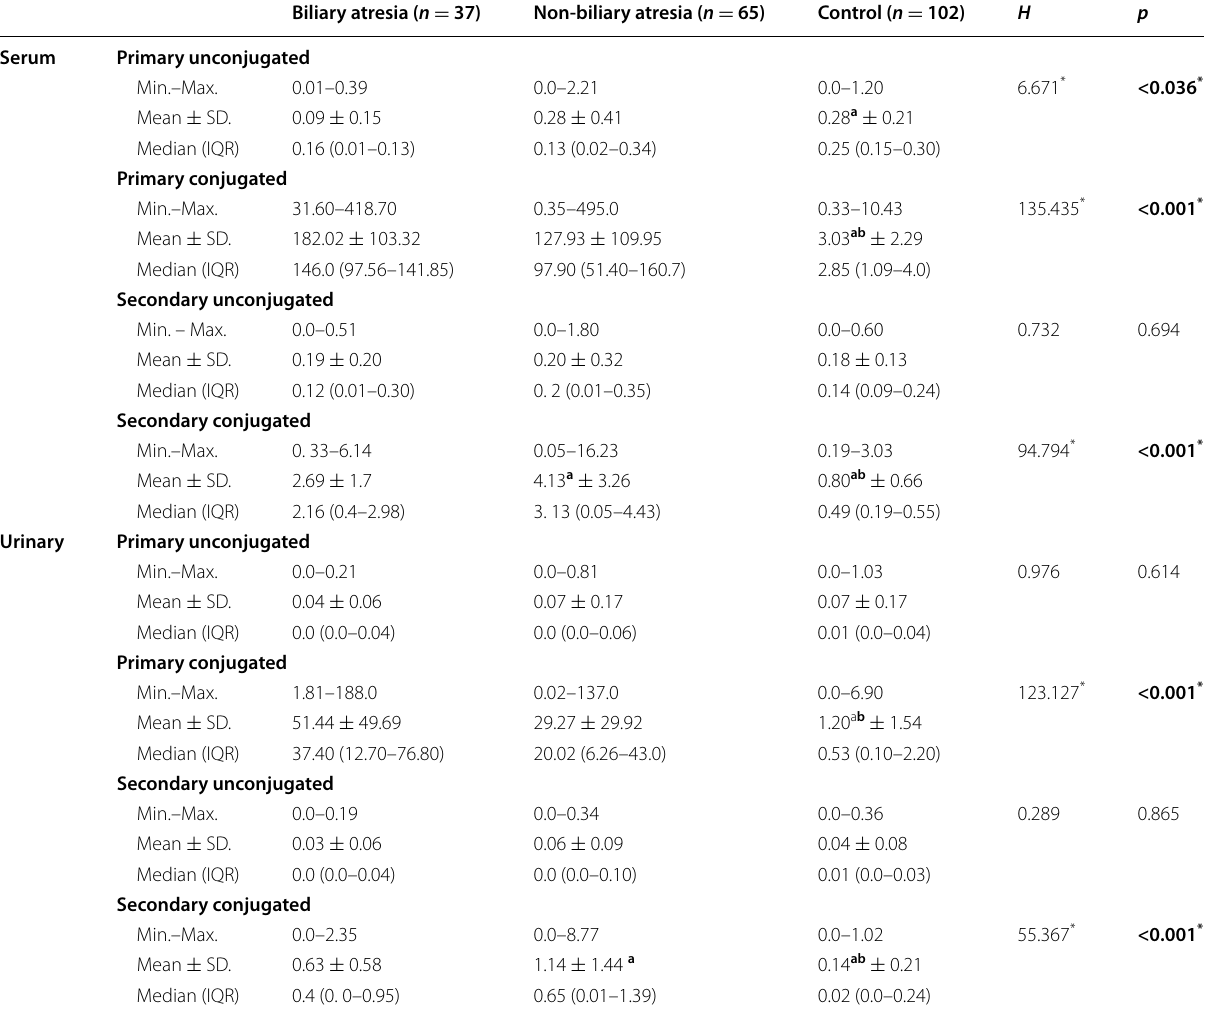
Table 3 Comparison between the two cholestatic groups (biliary atresia and non‑biliary) and control regarding primary and secondary bile acids in conjugated and unconjugated forms in serum and urine Biliary atresia ( n =